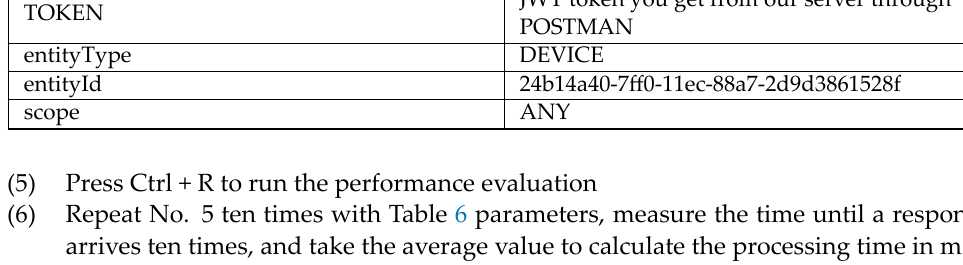
Table 6. Test results during ten times of repetition.